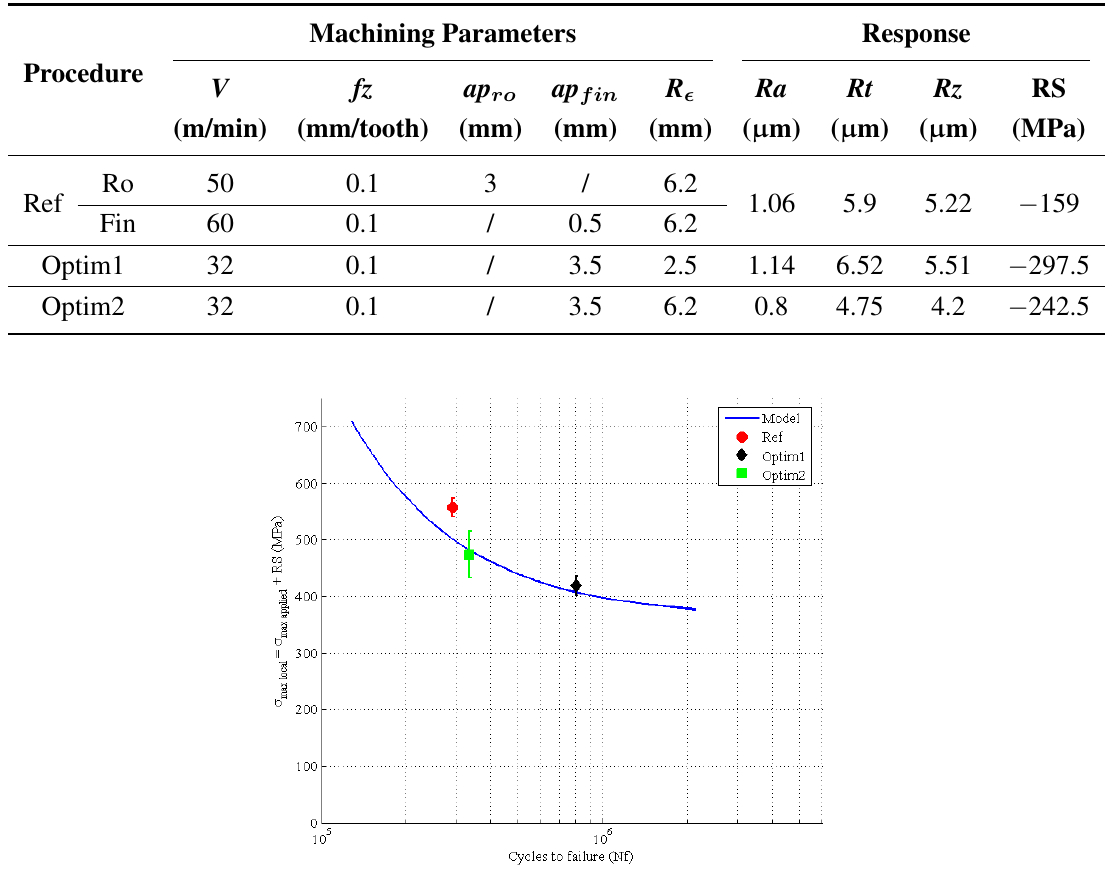
Figure 9. Comparison between optimized and Ref procedure for σ